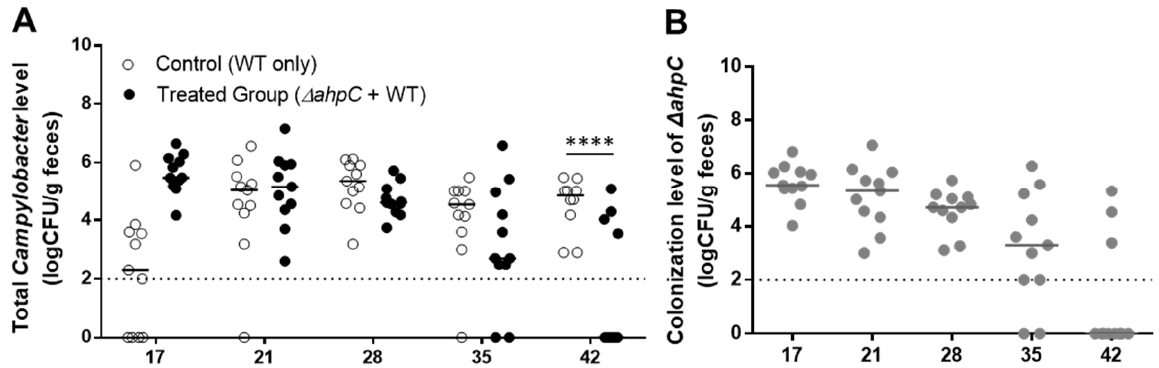
Figure 3. Efficacy of preventing C. jejuni colonization in chickens by two exposures to a low dose of the ∆ ahpC mutant. ( A ) Levels of chicken colonization of the total C. jejuni including the wild type and the ∆ ahpC mutant. ( B ) Colonization levels of the ∆ ahpC mutant. Day-old chicks were administered with a low dose (5 × 10 6 CFU/bird) of the ∆ ahpC mutant on days three and seven and challenged with the wild-type C. jejuni on day 10. Median values are indicated with lines. Statistical significance was calculated with two-way ANOVA with Sidak’s multiple comparison test (****: p < 0.0001). The dotted line is the detection limit.